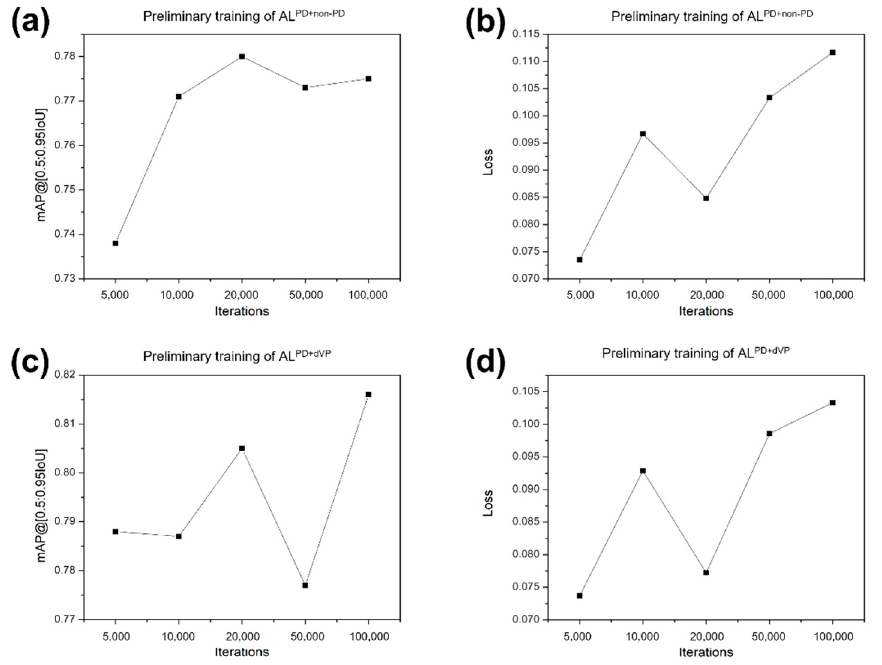
Figure 4. Mean average precision values and loss function values of the preliminary training. ( a , b ) Algorithm (AL) PD+non-PD and ( c , d ) AL PD+dVP at various iterations (5000, 10,000, 20,000, 50,000, and 100,000). AL PD+non-PD and AL PD+dVP represent the algorithm classifying parkinsonism in the training sets composed of the two groups Parkinson’s disease (PD) + non-PD and PD + definite vascular parkinsonism with prominent defect or decreased dopamine transporter binding mimicking PD (dVP). mAP, mean average precision.